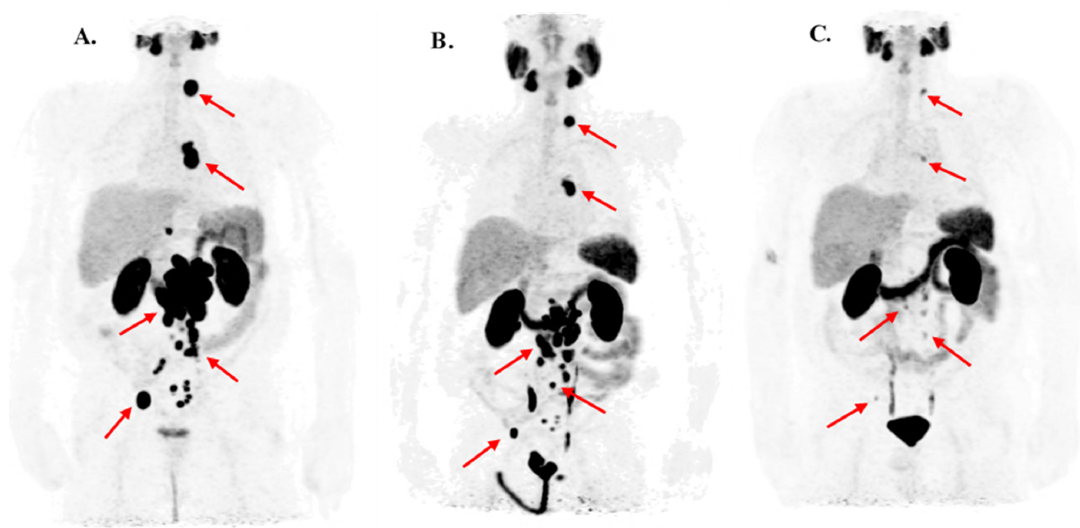
Figure 4. The [68Ga]-Ga-PSMA PET examination of an mCRPC patient with only lymph node metastasis who received two courses (each three cycles with 4-week interval) of PSMA-RLT. The [ 68 Ga]GaPSMA-11 PET images of a 76-year-old mCRPC patient. ( A ): prior the first cycle of first course of PSMA-RLT with clearly PSMA-overexpressed lymph node (LN) metastases in upper and lower diaphragm and a PSA value of 597 ng/mL. ( B ): one month after the third cycle of the first course of PSMA-RLT the metastatic LN were measured smaller with computed tomography (CT) and the PSA level declined to 81.2 ng/mL (reduction of 85%). ( C ): One month after the third cycle of the second course of PSMA-RLT, these LN were either tiny or completely disappeared in the CT and the PSA level dropped further to 0.93 ng/mL (reduction of >95%). The overall survival of this patient was 263 weeks from the beginning of the first cycle of first course and 227 weeks from the beginning of the first cycle of second course of the PSMA-RLT.